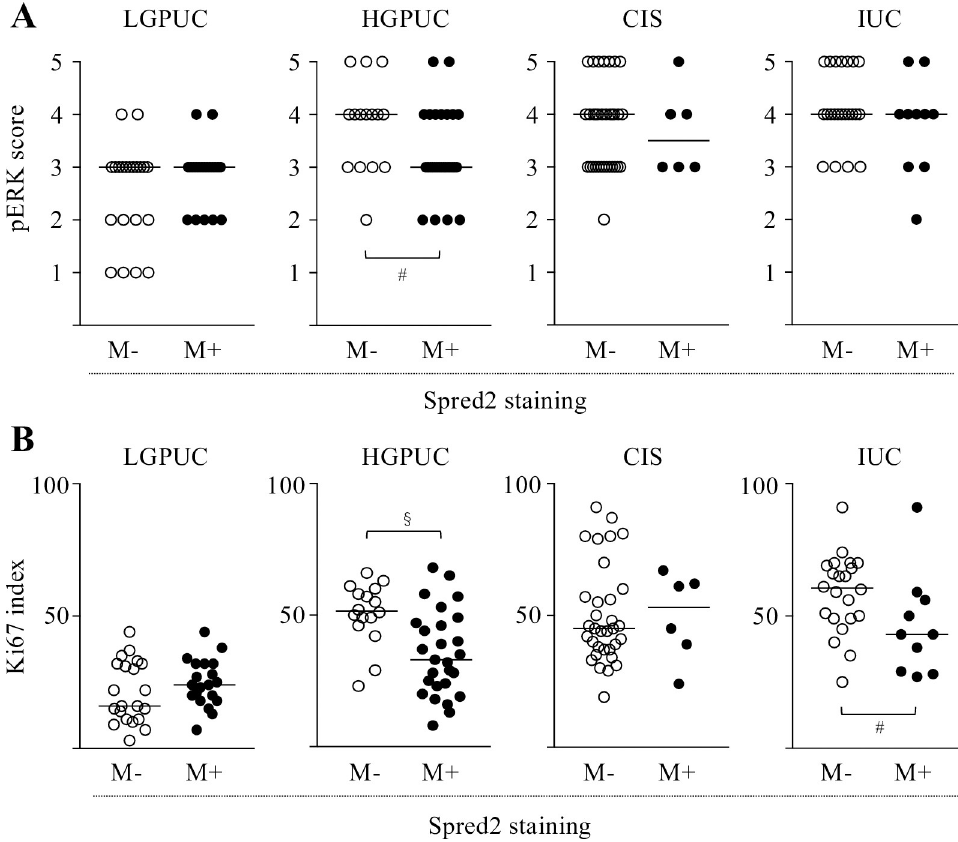
Fig 5. Comparison between pERK score/Ki67 index and membranous Spred2 expression. pERK score (A) and Ki67 index (B) were compared between membranous Spred2 negative (M-) and positive (M+) in cancer categories (LGPUC; n = 41 (M-:21, M+:20), HGPUC; n = 43 (M-:15, M+:28), CIS; n = 39 (N-:33, M+:6), and IUC; n = 32 (M-:22, M+:10)). Bar in each graph represents median. # p < 0.05, § p < 0.01 (Mann-Whitney test).